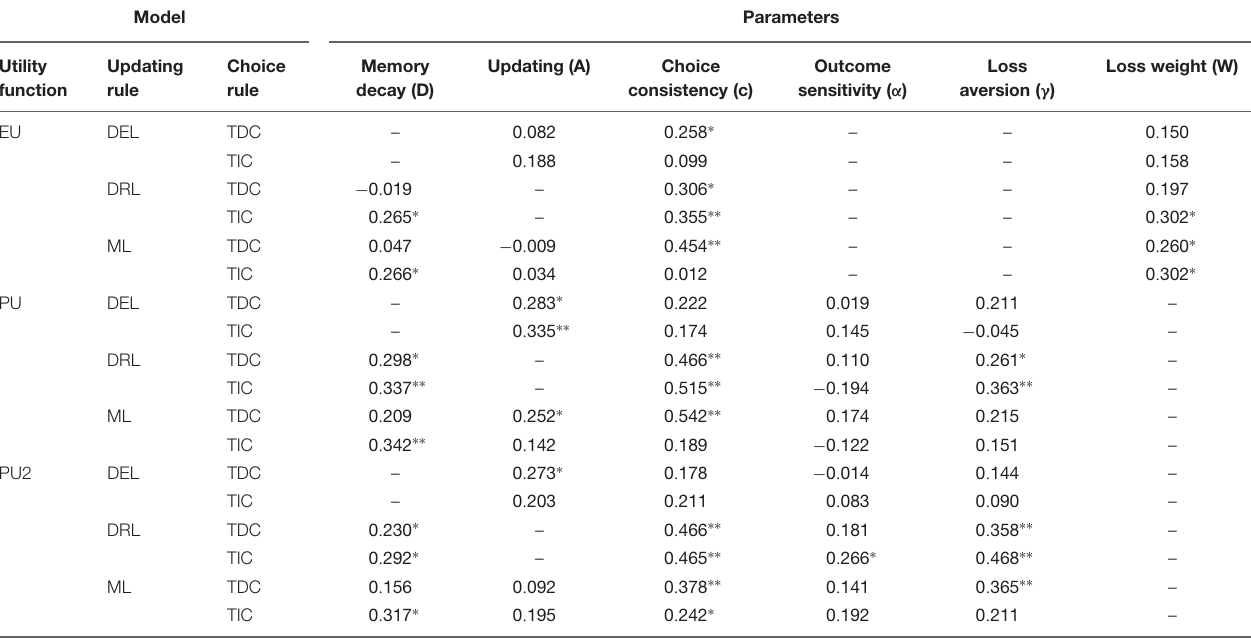
TABLE A1 | Correlations for parameters estimated from the IGT and SGT for all of the